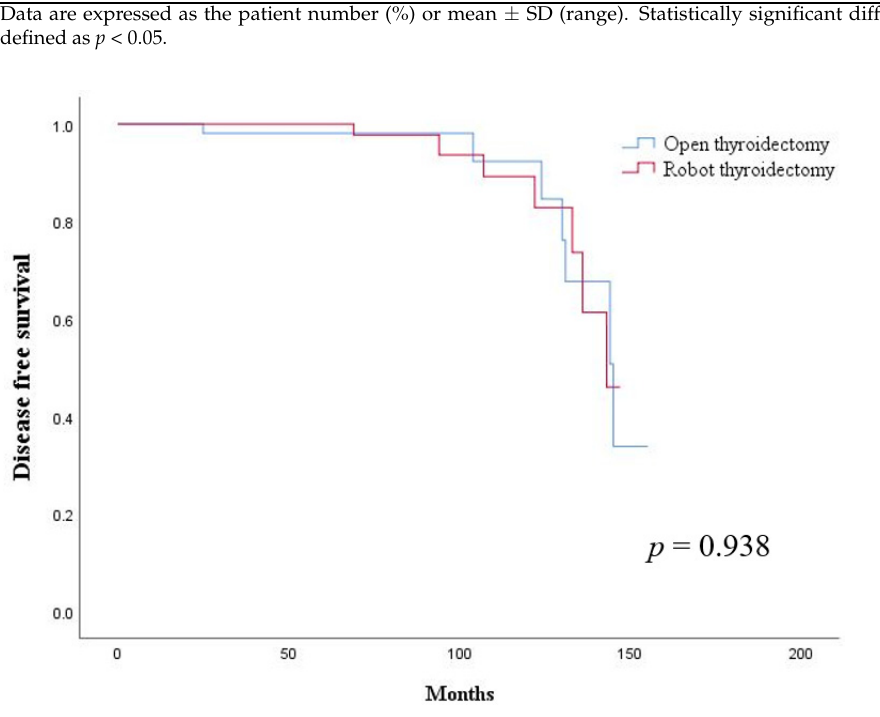
Figure 1. Disease-free survival between patients treated with robotic and open